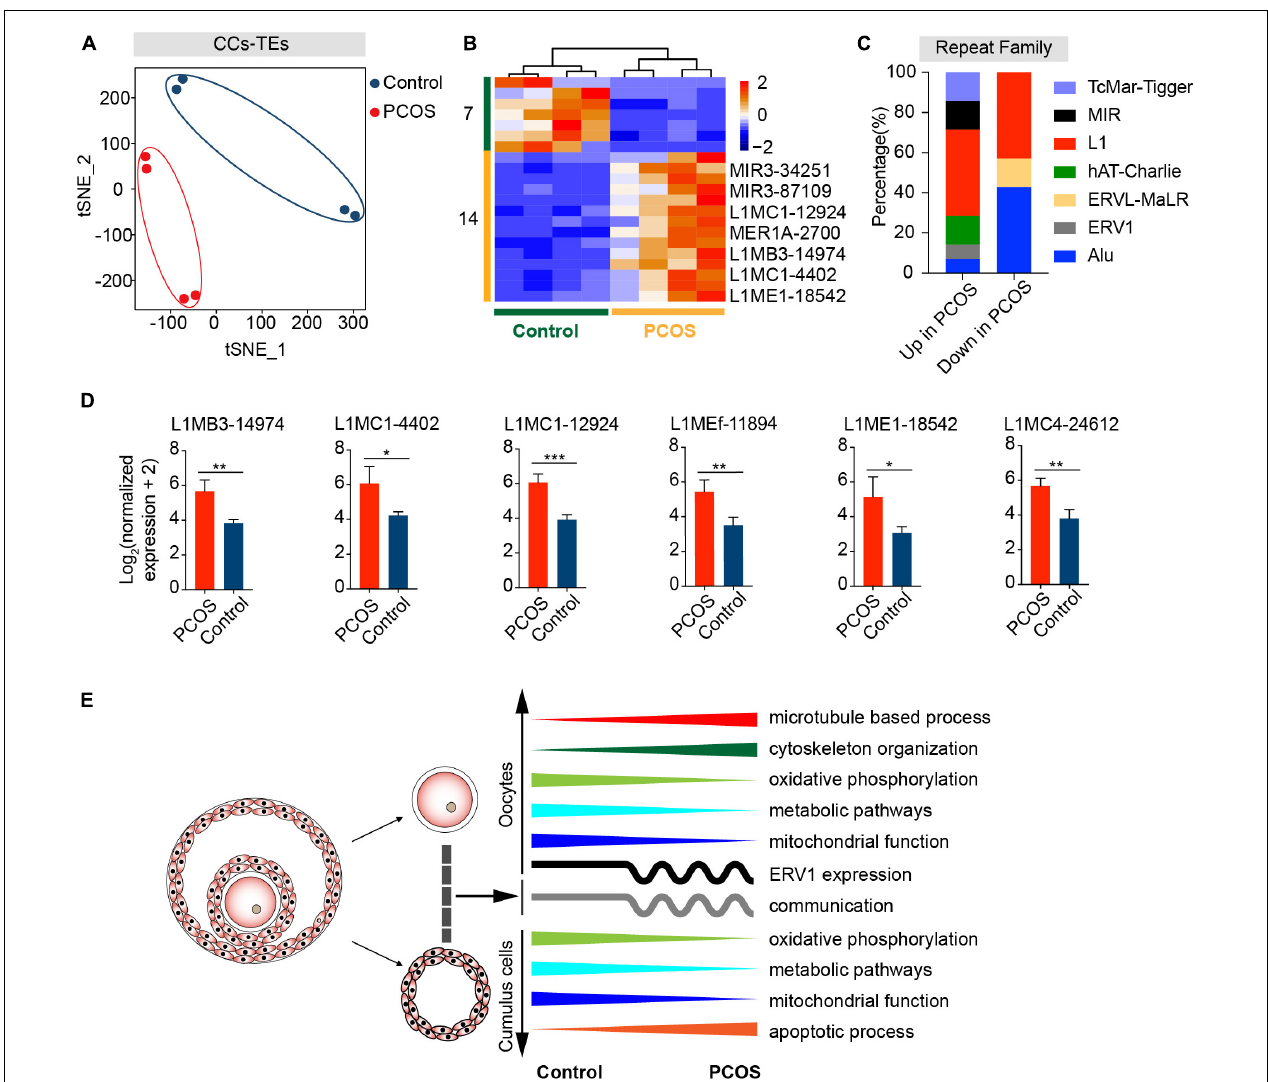
FIGURE 5 | Retrotransposons in PCOS and control CCs. (A) Visualization of TE expression of CCs by t-SNE, showing two clusters, including one for PCOS CCs (four samples) and the other for control CCs (four samples). Each dot corresponds to CCs. (B) Heat map of all differentially expressed TEs (DETs) in CCs